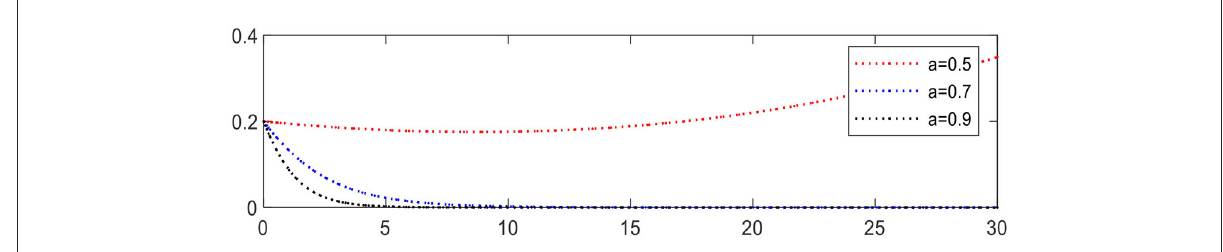
FIGURE11 Evolution of physical medical institutions (different α ).